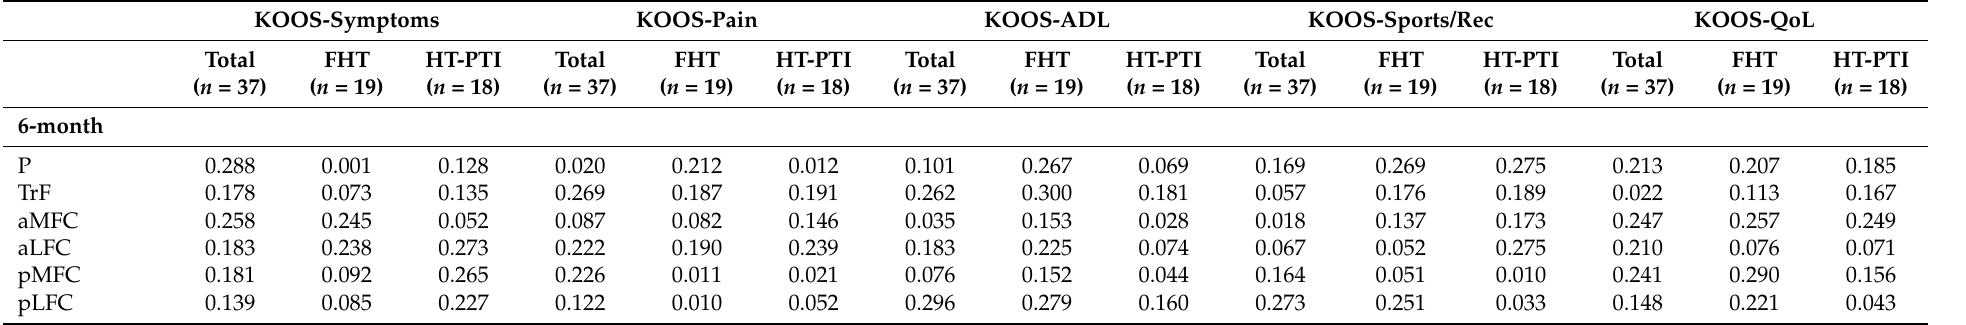
Table A2. Correlation between value CV% and KOOS of each cartilage sub-region after operation ( r value). KOOS-Symptoms KOOS-Pain KOOS-ADL KOOS-Sports/Rec